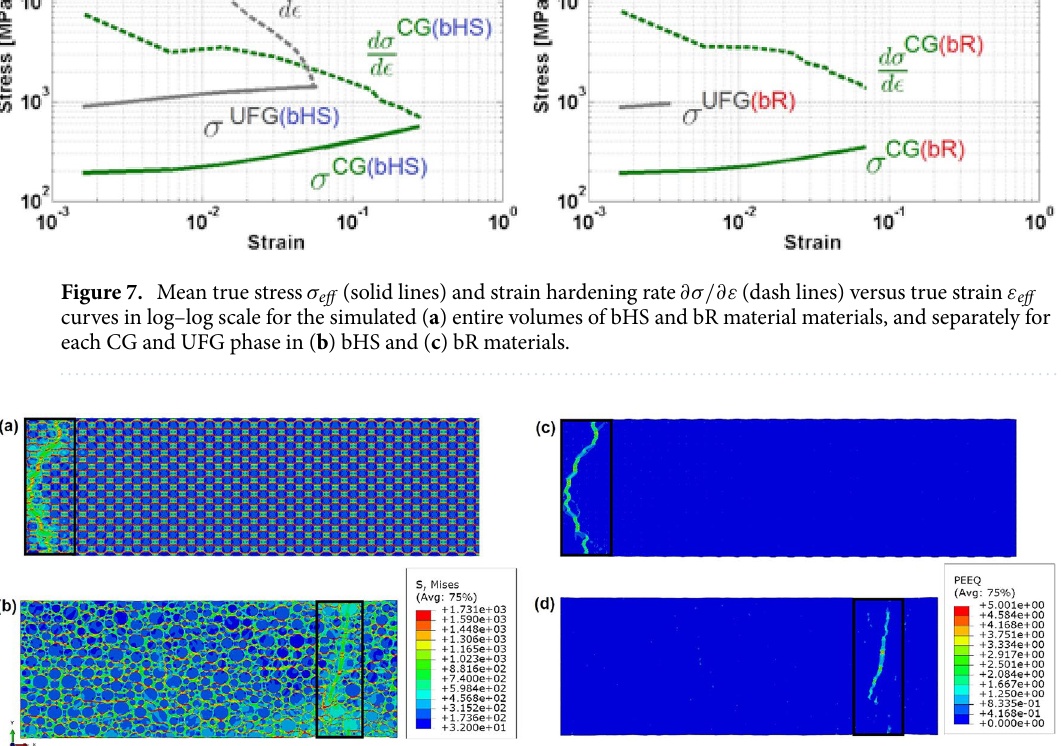
Figure 8. Distribution of von Mises stresses ( a , b ) and plastic strains ( c , d ) at a global strain ε eff = 0.2 in bHS ( a , c ) and bR ( b , d ) materials. The areas of ultimate plastic instability outlined by black squares are shown in greater details at various global strain levels in Fig.